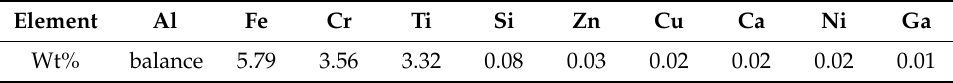
Table 1. Composition (in wt%) of the aluminum alloy